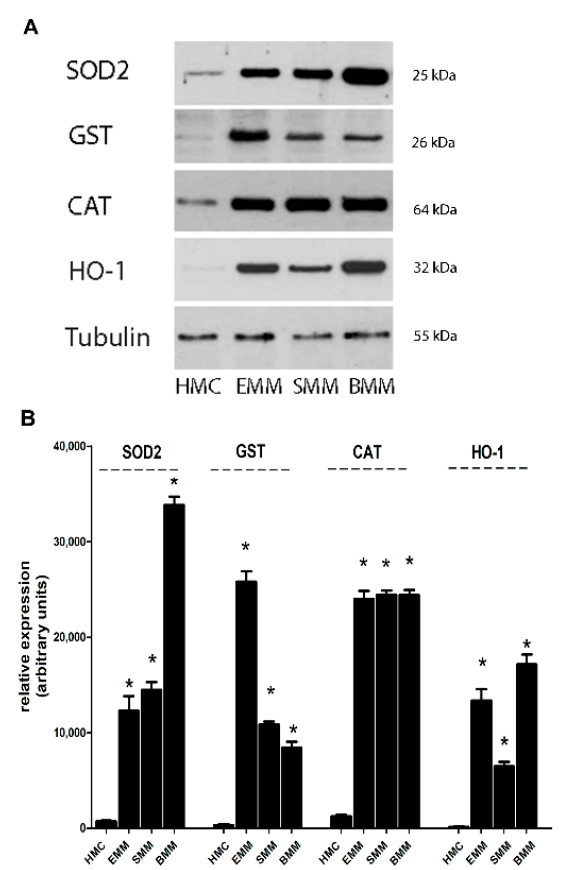
Figure 3. Expression of antioxidant genes induced by Nrf2 and FOXM1 in MPM cells. ( A ) Western Blot of SOD2, GST, CAT, HO-1, and Tubulin proteins in HMC, EMM, SMM, and BMM cells. ( B ) Densitometric analysis of the relative expression of SOD2, GST, CAT, and HO-1 ( n = 3, * p < 0.001). As Nrf2, also FOXM1 activated the antioxidant proteins SOD2 and CAT in MPM cells towards HMC (Figure 3A,B), so counteracting oxidative stress in tumor